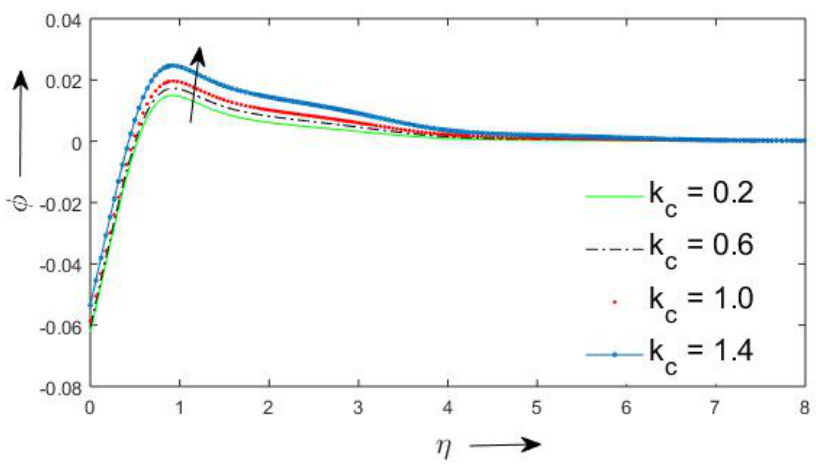
Figure 15: Distribution concentration due to k